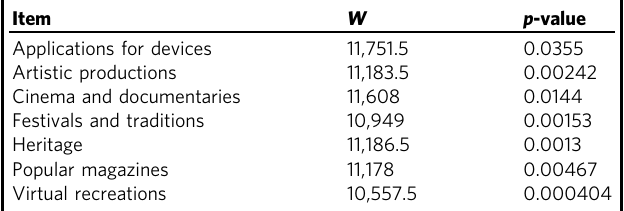
Table 3 Summary of the inference results by sex. Item W p -value